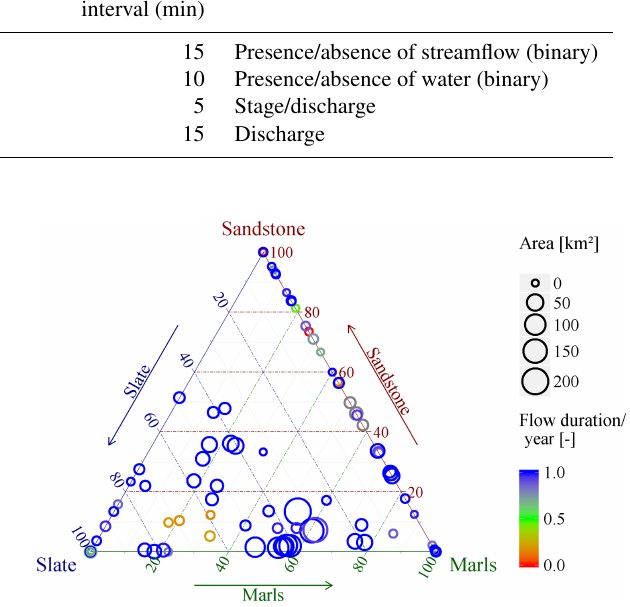
Figure 6. Measurement sites in relation to the proportion of pre- dominant bedrock geology within their catchments. Catchment area is indicated by the size of each circle while the flow duration per year is shown by the colour scale (grey colours missing data from downstream of the Attert gauge at Useldange). Larger catchments in the Attert basin typically have a higher proportion of slate and marl bedrock geology while smaller headwater catchments often host only one or two of the three predominant